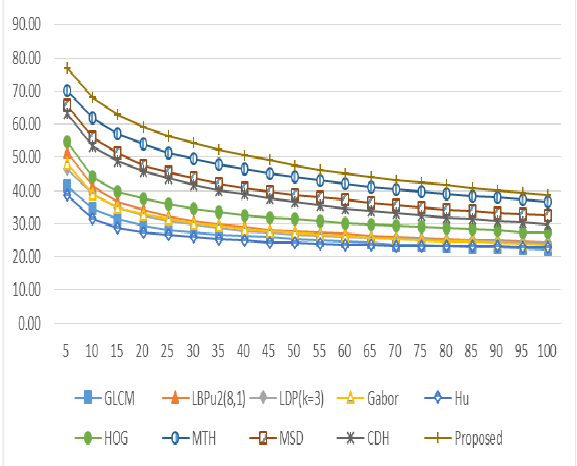
Fig.3. The average precision with different number of returned images